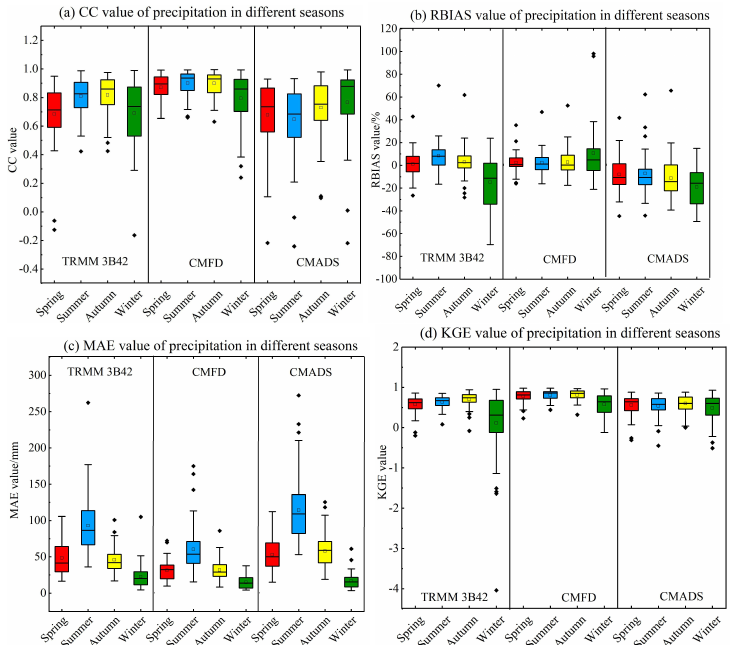
Figure 4. Box plots of statistical indicators for 3 sets of precipitation products in different seasons. The diamonds represent the minimum and maximum values and the small rectangles indicate the mean